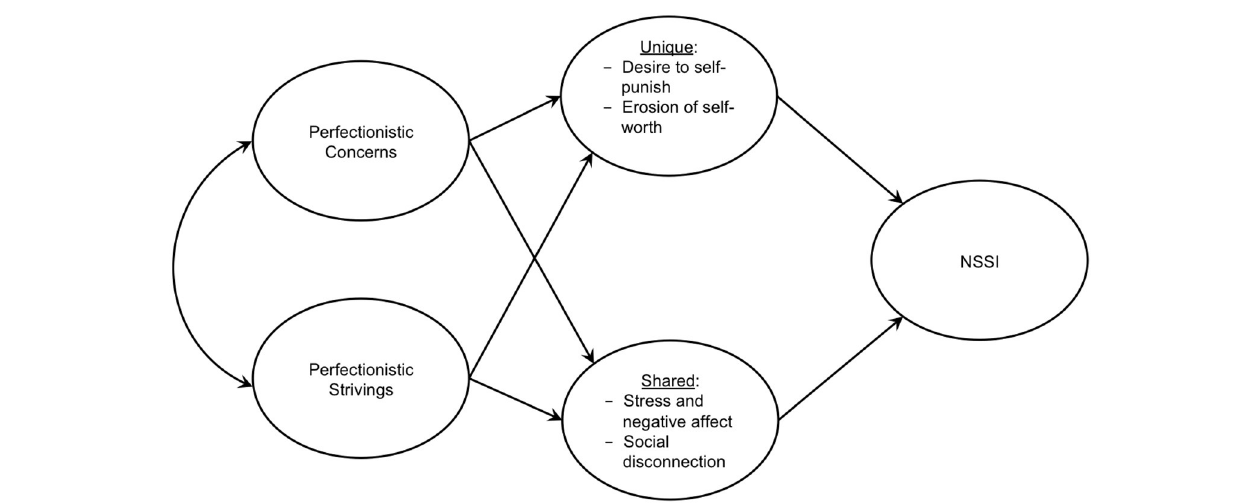
FIGURE 1 | Proposed Pathways from Trait Perfectionism to NSSI. We propose that perfectionism uniquely exacerbates risk for NSSI via heightened desire to self-punish and erosion of self-worth, as well as through common pathways established for other mental health concerns. It is likely that the link from perfectionism to NSSI is also moderated by other risk factors for NSSI (e.g., low aversion to